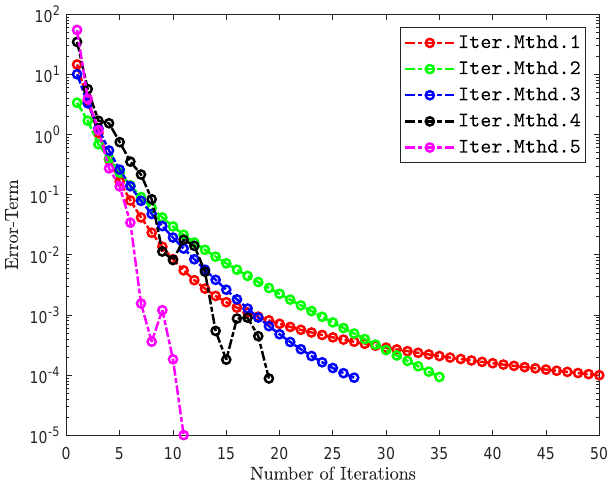
Figure 5. All techniques are computationally examined while s 0 = ( 2,2,3, − 4,4 ) T .